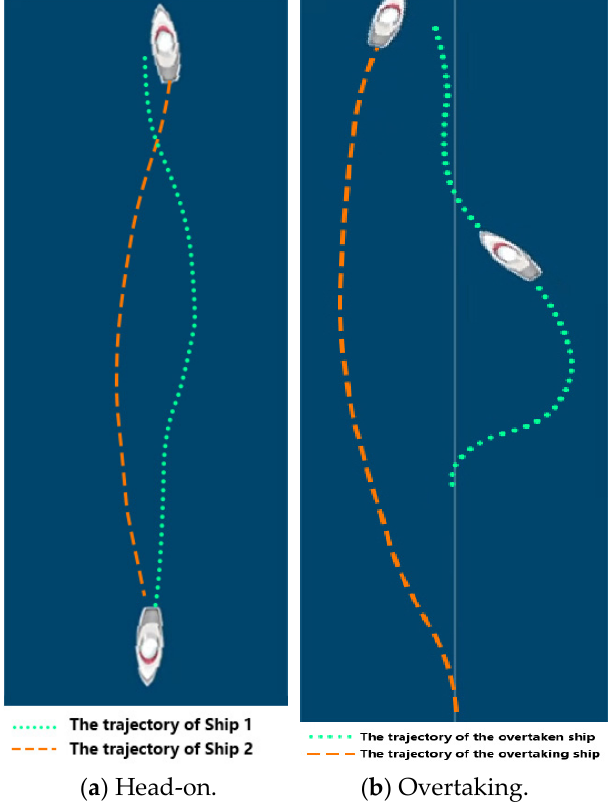
Figure 4. The trajectories of ship agents in the collision avoidance process.